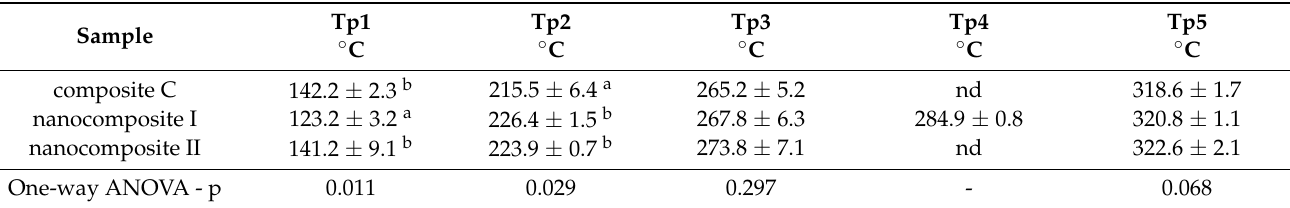
Figure 3. DSC curves of thin control composite C, and nanocomposites I and II. Table 3. Temperature values of characteristic peaks.